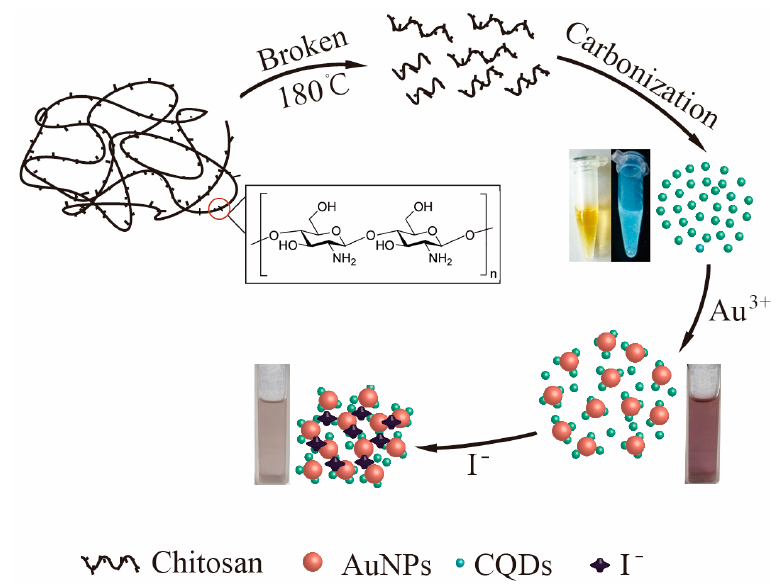
Scheme 1. Schematic illustration of preparing CQDs and CQDs/AuNPs, and illustration of the detection of I − based on CQDs/AuNPs. The yellow and blue liquid in centrifuge tube is photograph of CQDs illuminated by natural light and UV lamp with 365 nm light, respectively.